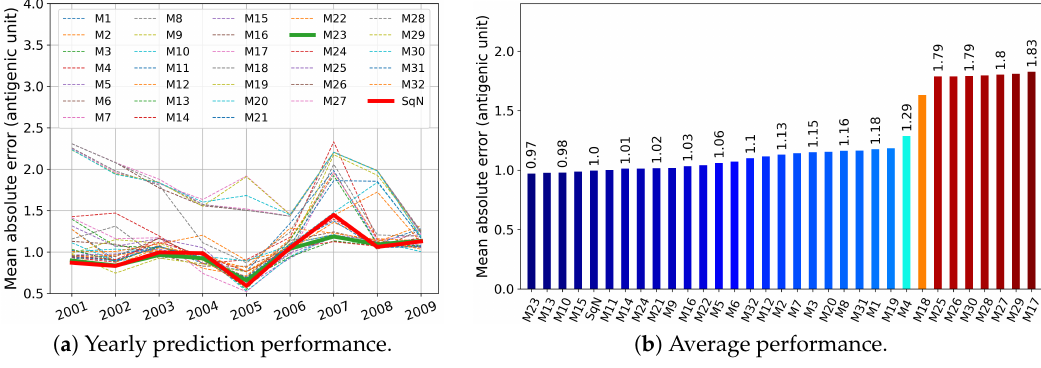
Figure 10. Experiment T 5 : the models were trained on a five-year prehistory.